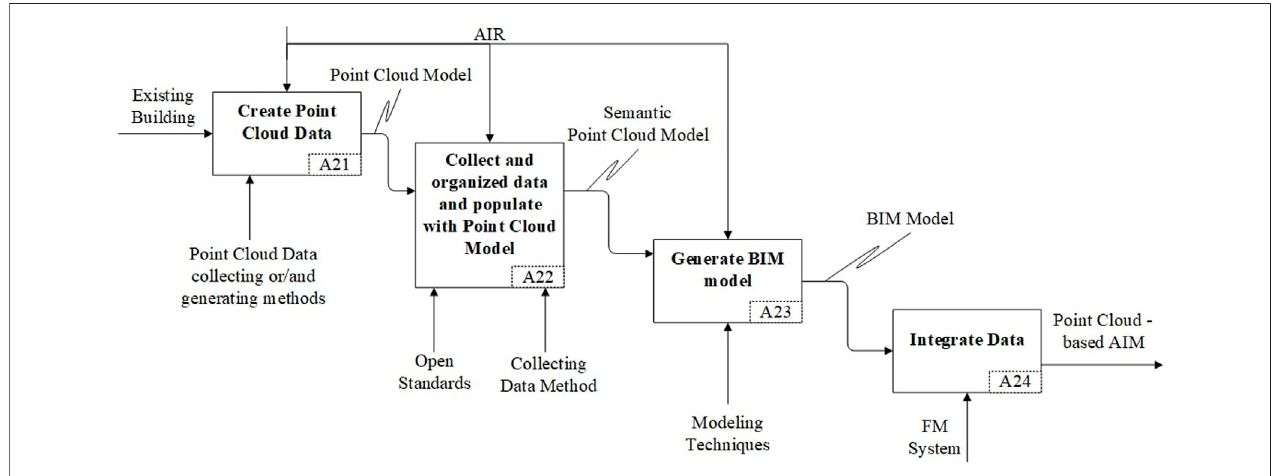
FIGURE 5 | Process model of the development of the asset information model